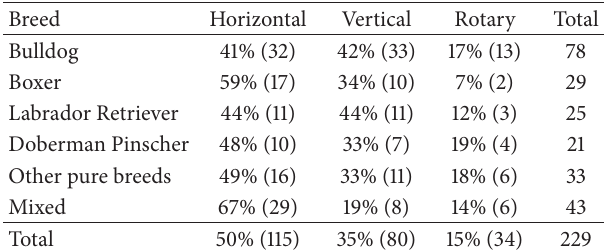
Table 3: Duration of head tremors.